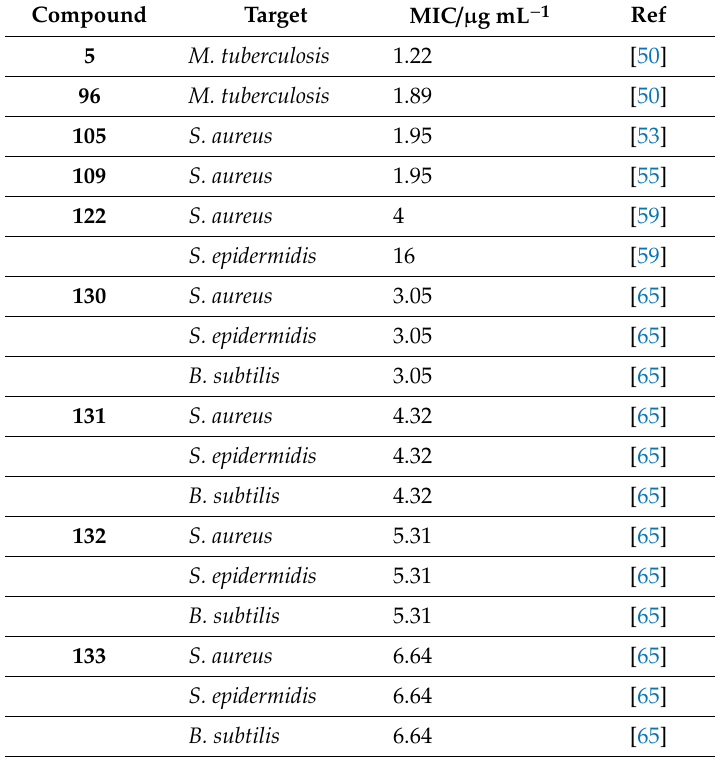
Table 2. Summary of macrocycles with significant cytotoxic effects on bacterial and fungal species. Compound